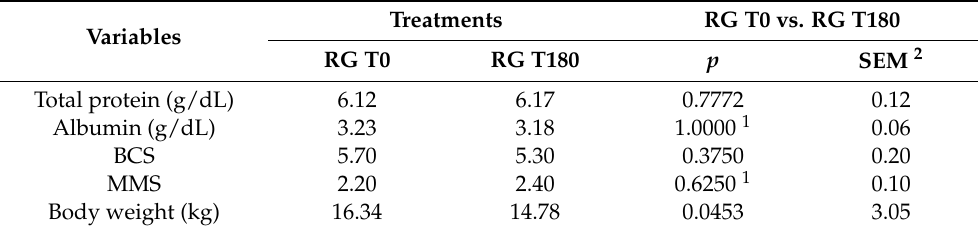
Table 2. Serum concentrations of total protein, albumin, body condition score (BCS), muscle mass score (MMS), and body weight of dogs with chronic kidney disease before (RG T0) and after 180 days (RG T180) of therapeutic renal diet intake.